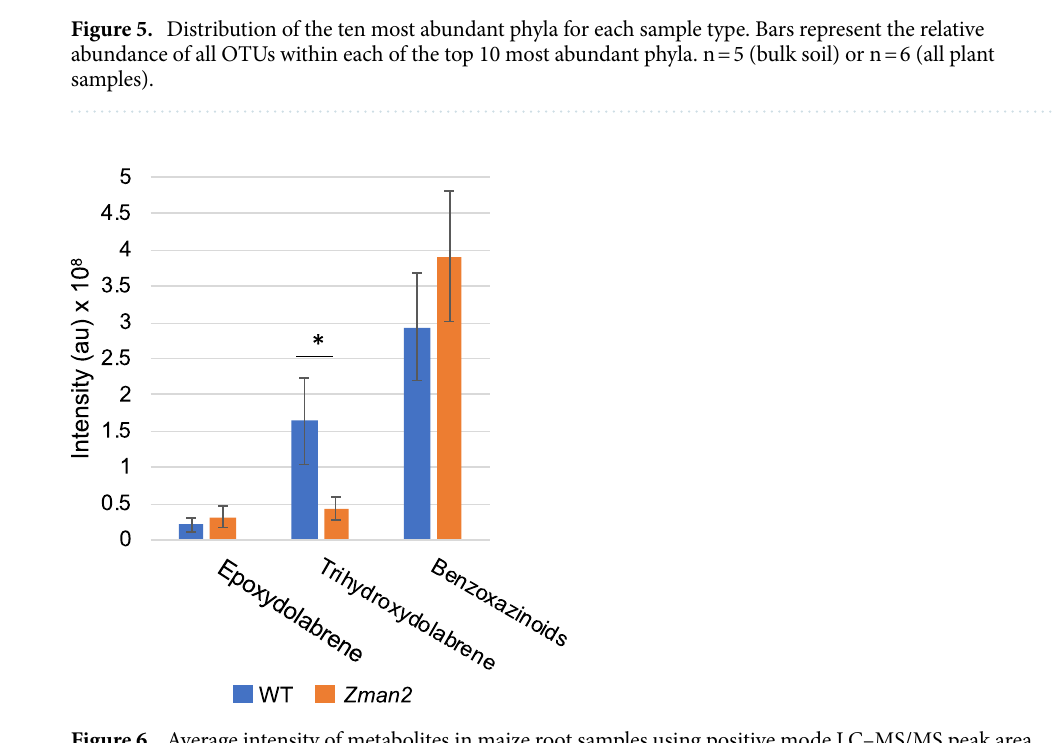
Figure 6. Average intensity of metabolites in maize root samples using positive mode LC–MS/MS peak area. Peak area based on epoxydolabrene [M + H], trihydroxydolabrene [M + H-H2O], and benzoxazinoids, with the last based on detection of metabolites containing BOA (1,3-benzoxazol-2-one (BOA) [M + H]). * represents significant difference between two samples p ≤ 0.1. Two-tailed t-tests were used for benzoxazinoids; one-tailed t-tests were used for the remaining metabolites, since they are predicted to be enriched in WT and deficient in Zman2 ; n = 4 ( Zman2 ) or n = 5 (WT). Error bars represent standard